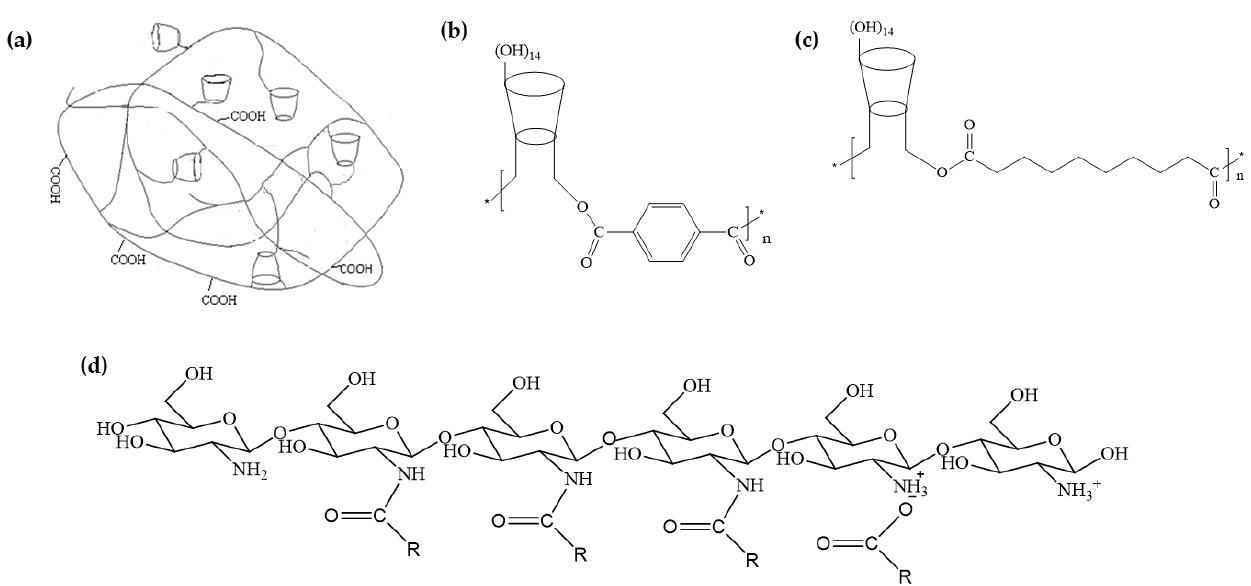
Scheme 2. Schematic molecular structure of polysaccharide adsorbents: ( a ) β-CD/PAA copolymer,